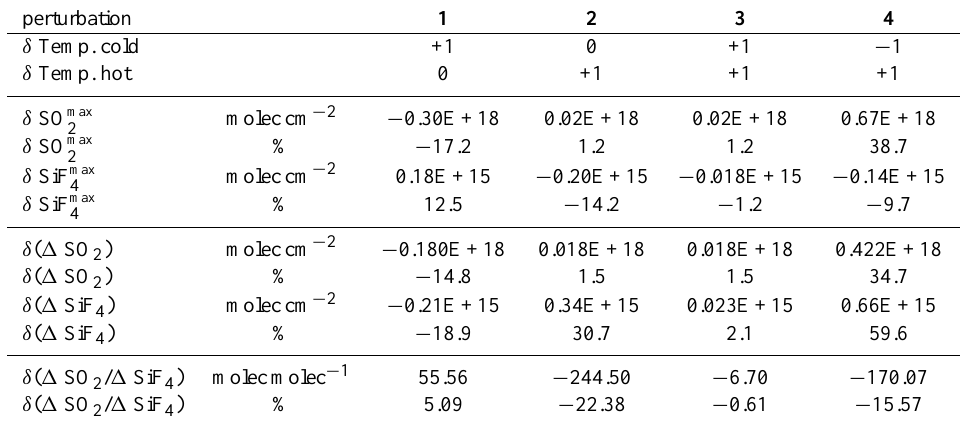
Fig. 11. Left panel: on-line analysis of the SO 2 and SiF 4 plumes displaying the retrieved slant columns in false-colored images. Difference spectra were calculated using the outermost left pixel as background and a temperature of 280K was assumed for the evaluation. The sum of the slant columns within this window corresponds to 12t of SO 2 and 24kg of SiF 4 . Right panel: correlation between the column-densities of both gases in the scanned window resulting in a SiF 4 /SO 2 ratio of (1.80 ± 0.034) × 10 − 3 . Table 1. Sensitivity to calibration: study with lunar-background measurements assuming a temperature of 273 K of the volcanic plume. The calibration temperatures were 284.45 and 292.55